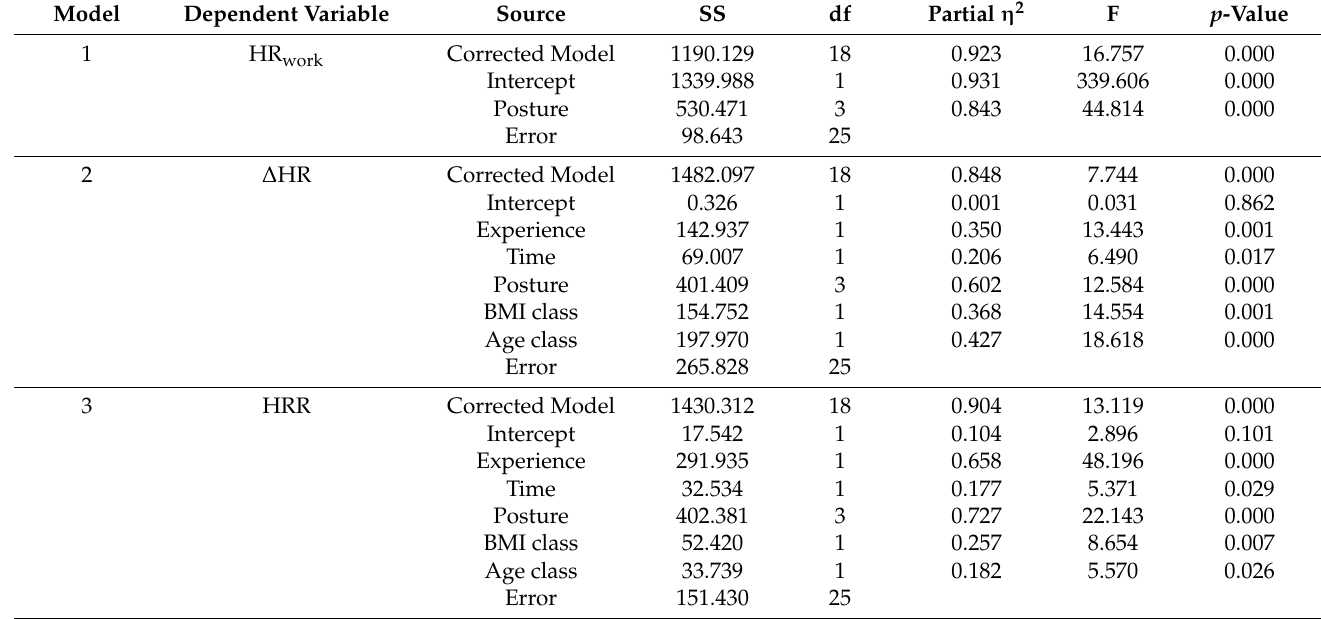
Table 7. ANOVA table for the GLM examining the heart rate during work (HR work ), the increase over the resting heart rate during tree felling ( ∆ HR), and the relative heart rate index (HRR).